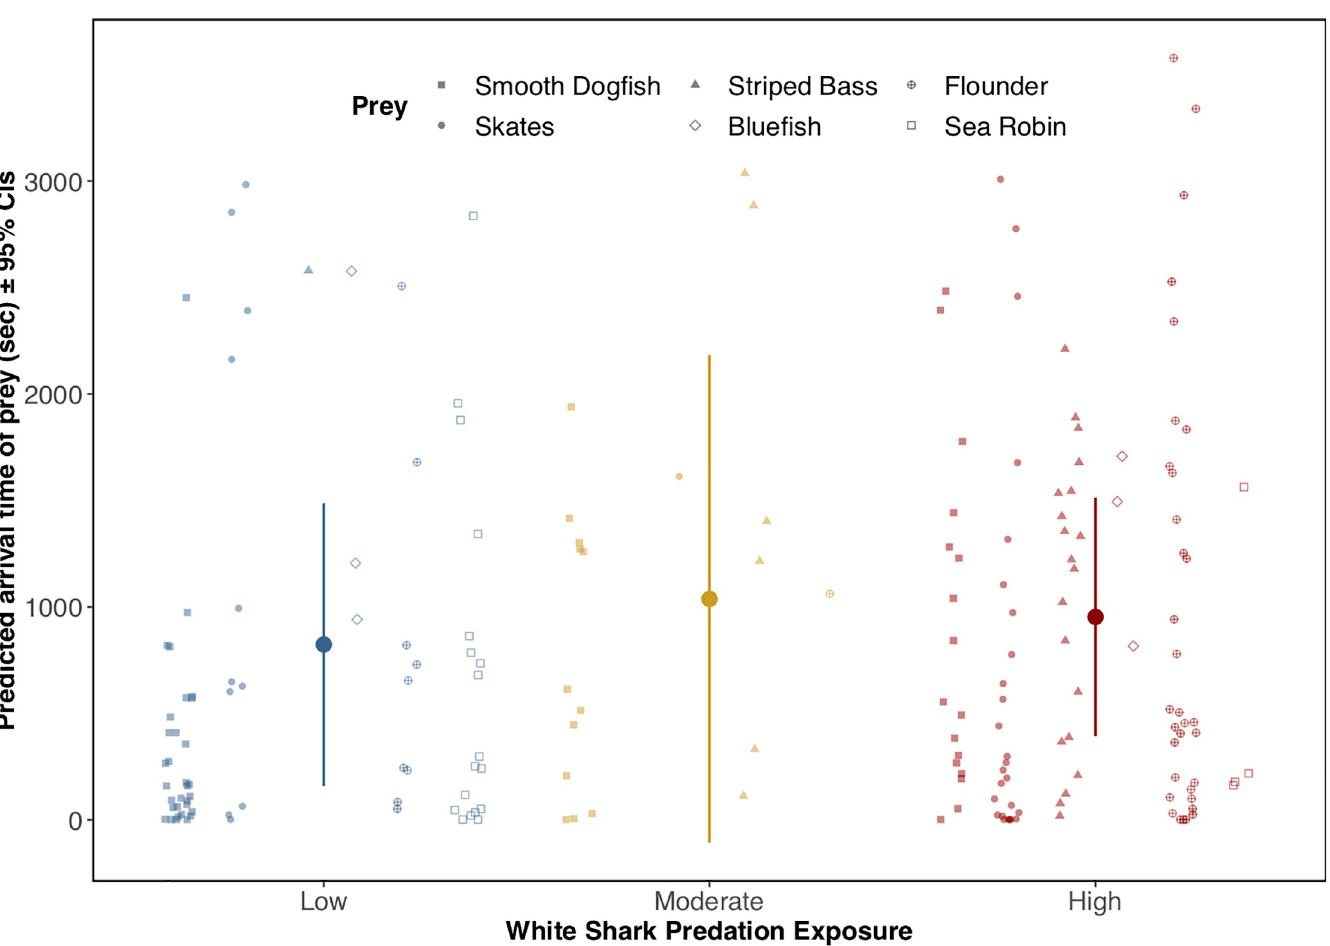
Fig 5. Predicted prey arrival times across a gradient of shark exposure. Predicted prey arrival times in seconds ( ± 95% confidence intervals) from a negative binomial GLM across varying levels of shark exposure. Predicted values are overlaid on top of raw observational data for the six prey groups.